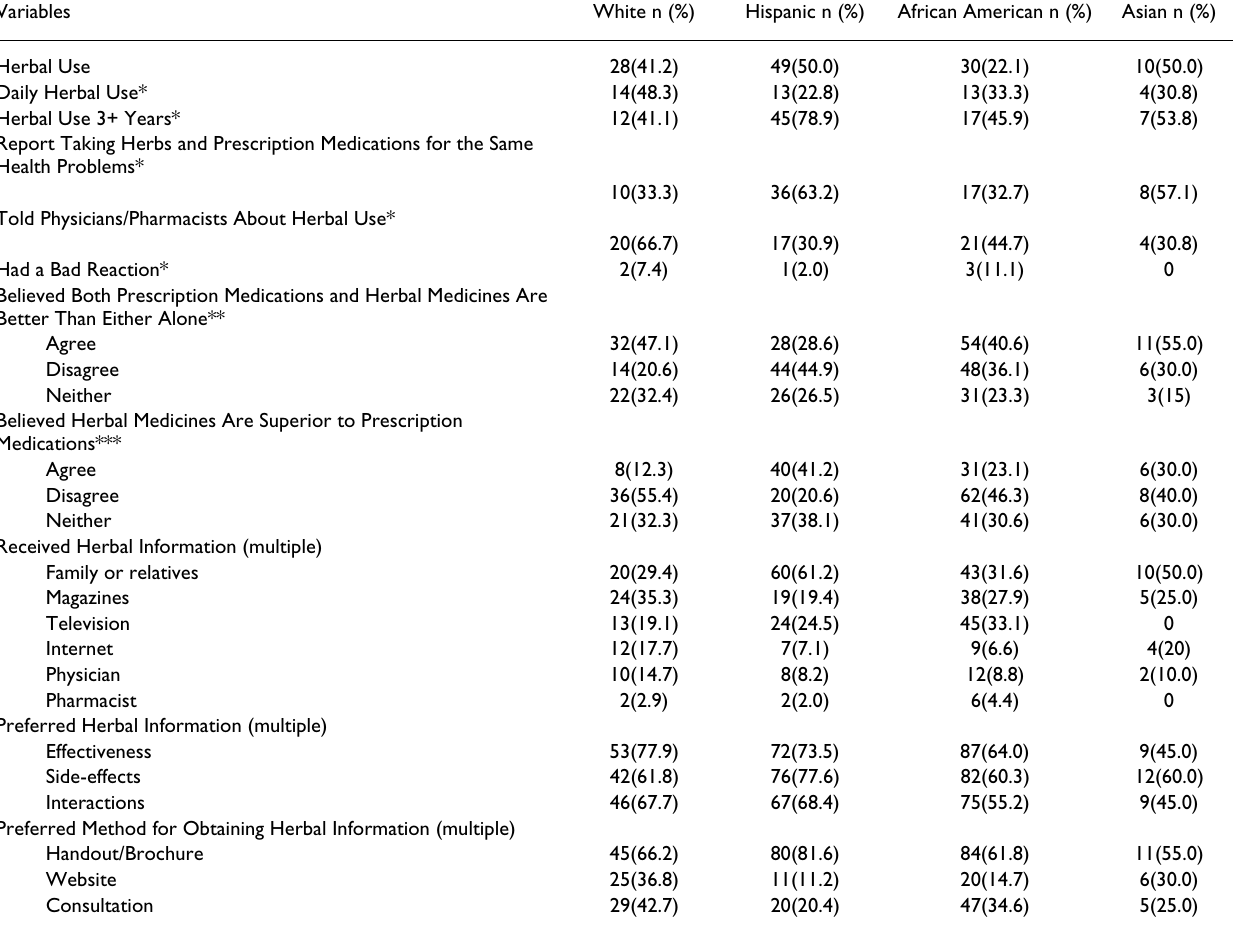
Table 2: Patterns of and Reasons for Herbal Use Among Urban Multiethnic Primary Care Patients (n = 322) Variables